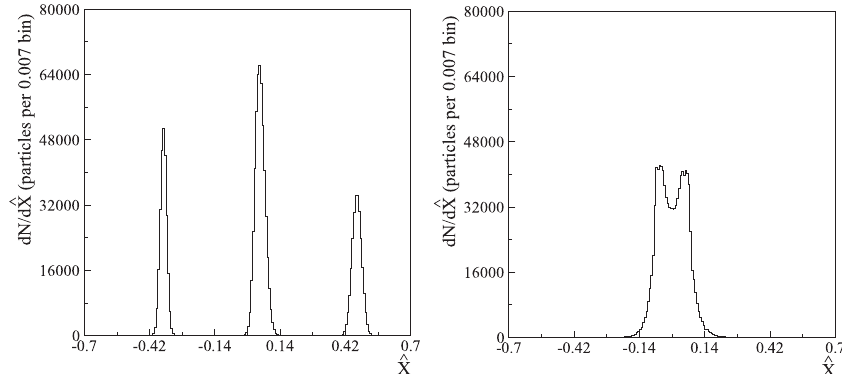
FIG. 2. Projected distribution functions for the four-turn injection right after the injection (left) and at the end of the merging process (right). The two islands centered at the origin with opposite angles are projected onto the central peak visible in the initial distribution function.